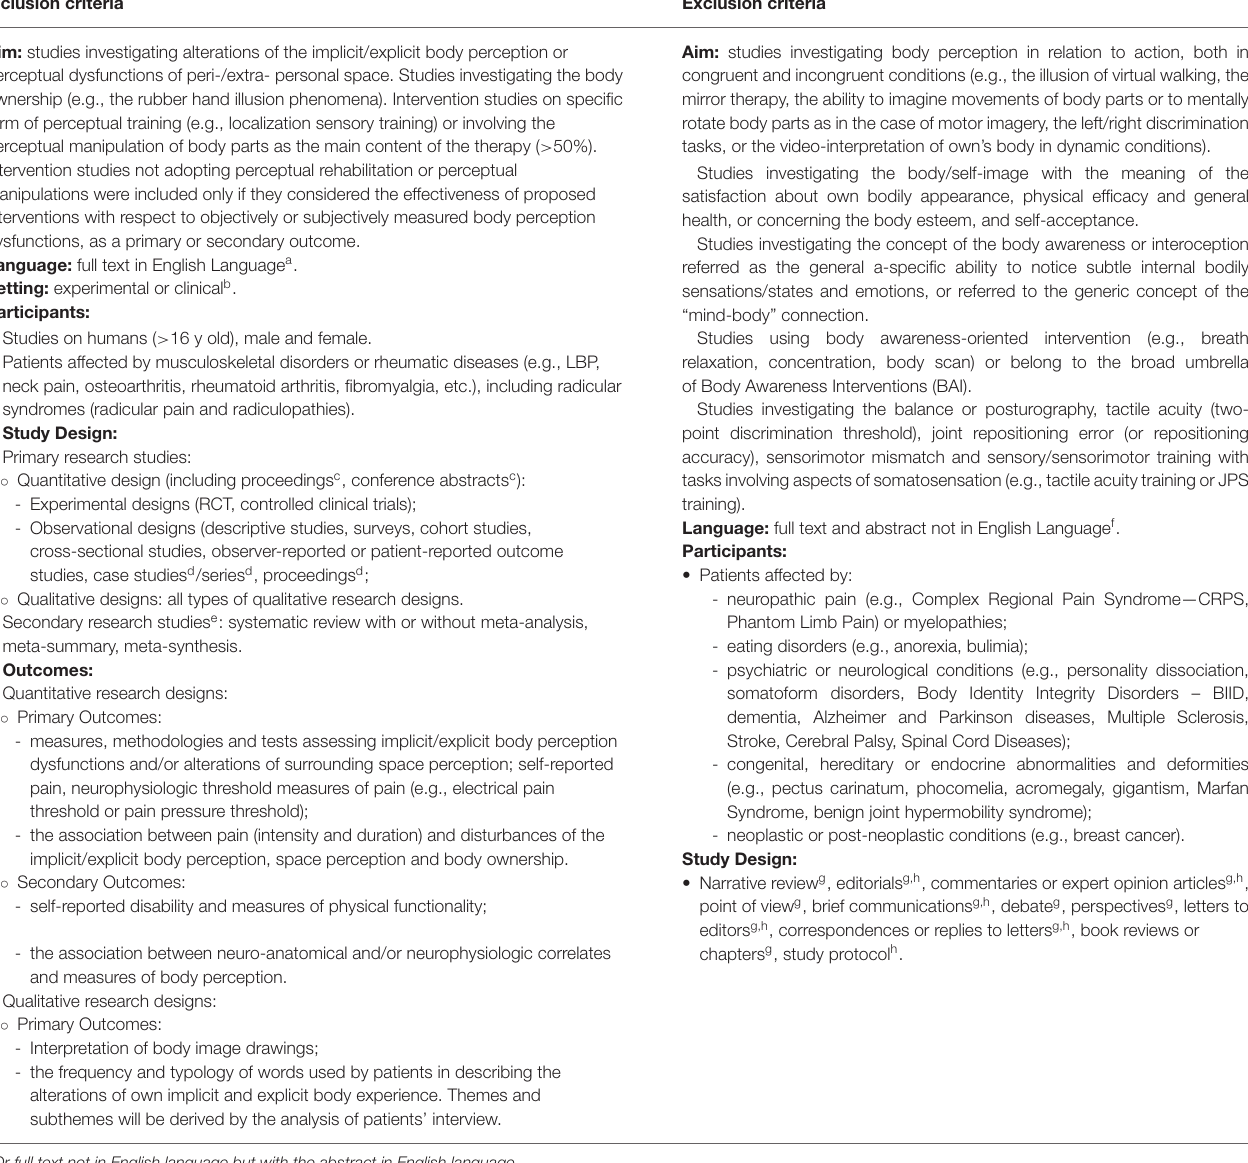
TABLE 2 | Eligibility criteria for inclusion and exclusion studies. Inclusion criteria Exclusion